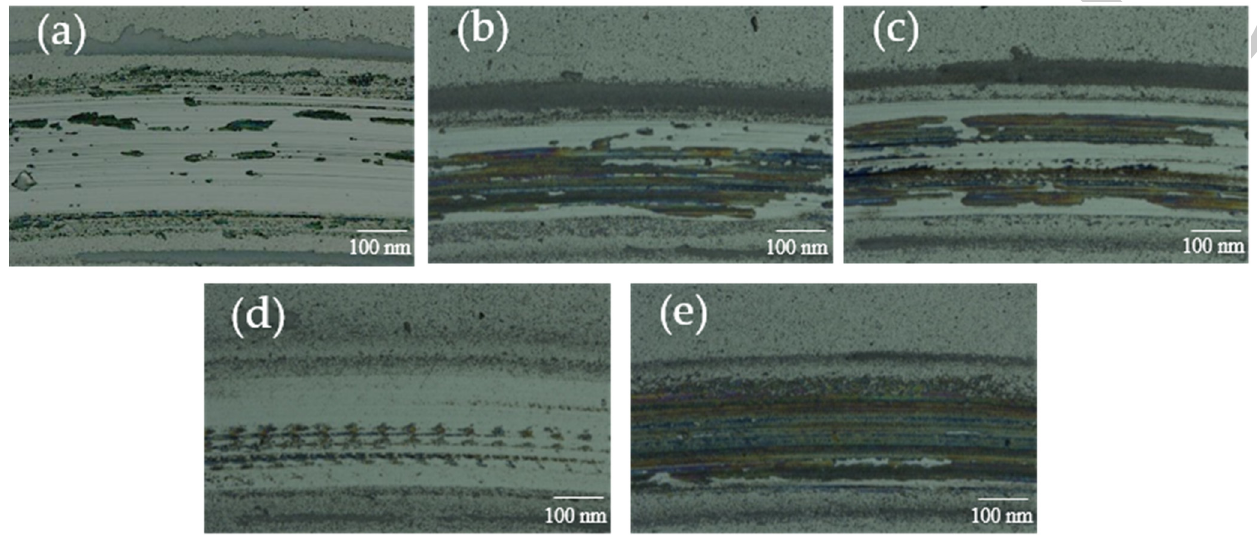
Figure 11. Wear morphologies of the AlCrTiSiN coatings before and after annealing. ( a ) as-deposited, annealed at ( b ) 600 °C, ( c ) 700 °C, ( d ) 800 °C, ( e ) 900 °C.